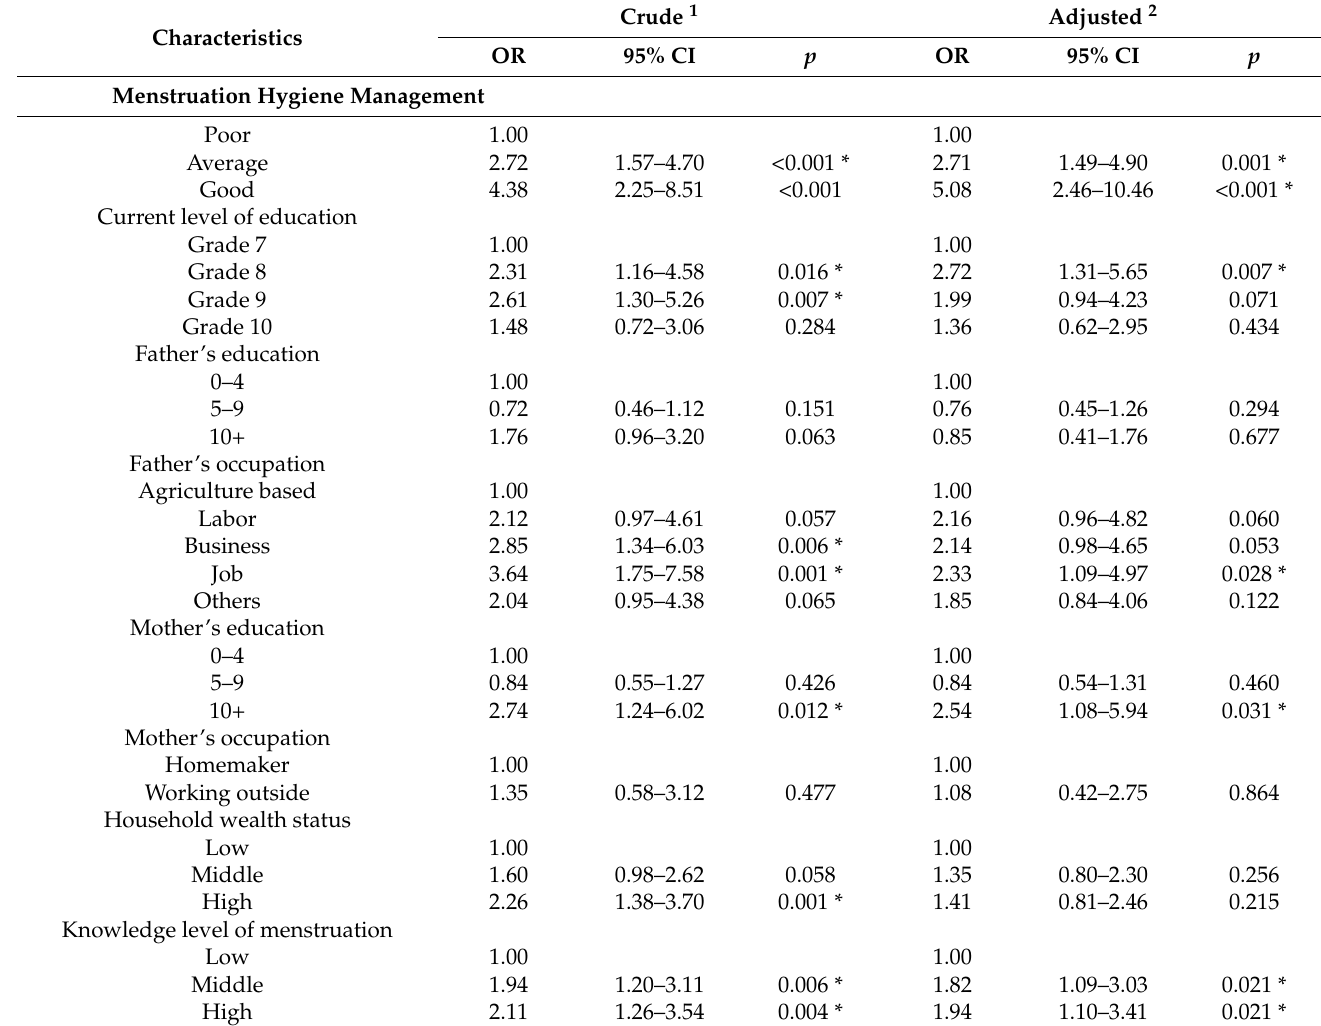
Table 3. Regression models of menstrual hygiene management and socio-demographics with academic performance of the adolescent